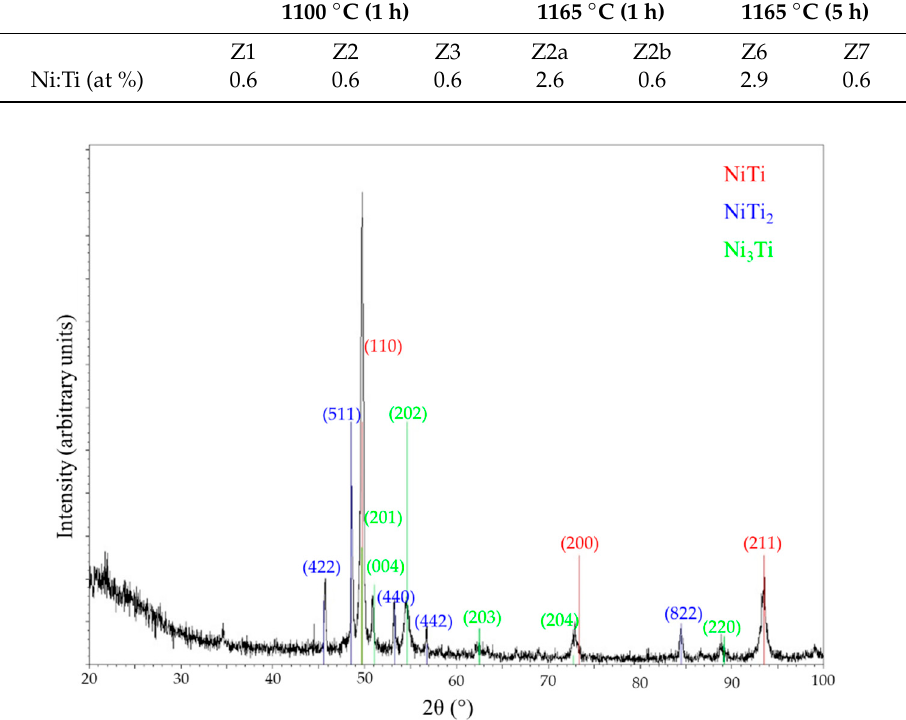
Figure 11. X-ray di ff ractogram of the NiTi specimens sintered at 1165 ◦ C (5